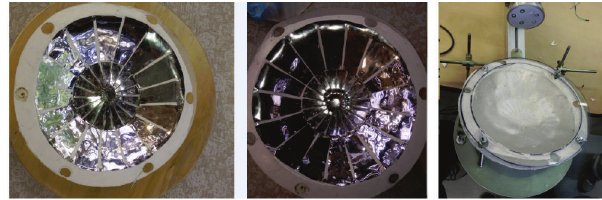
Figure 2: Several RF-reflecting materials were tested; they all had high reflecting results, but connecting them to the flexible surface was troublesome.